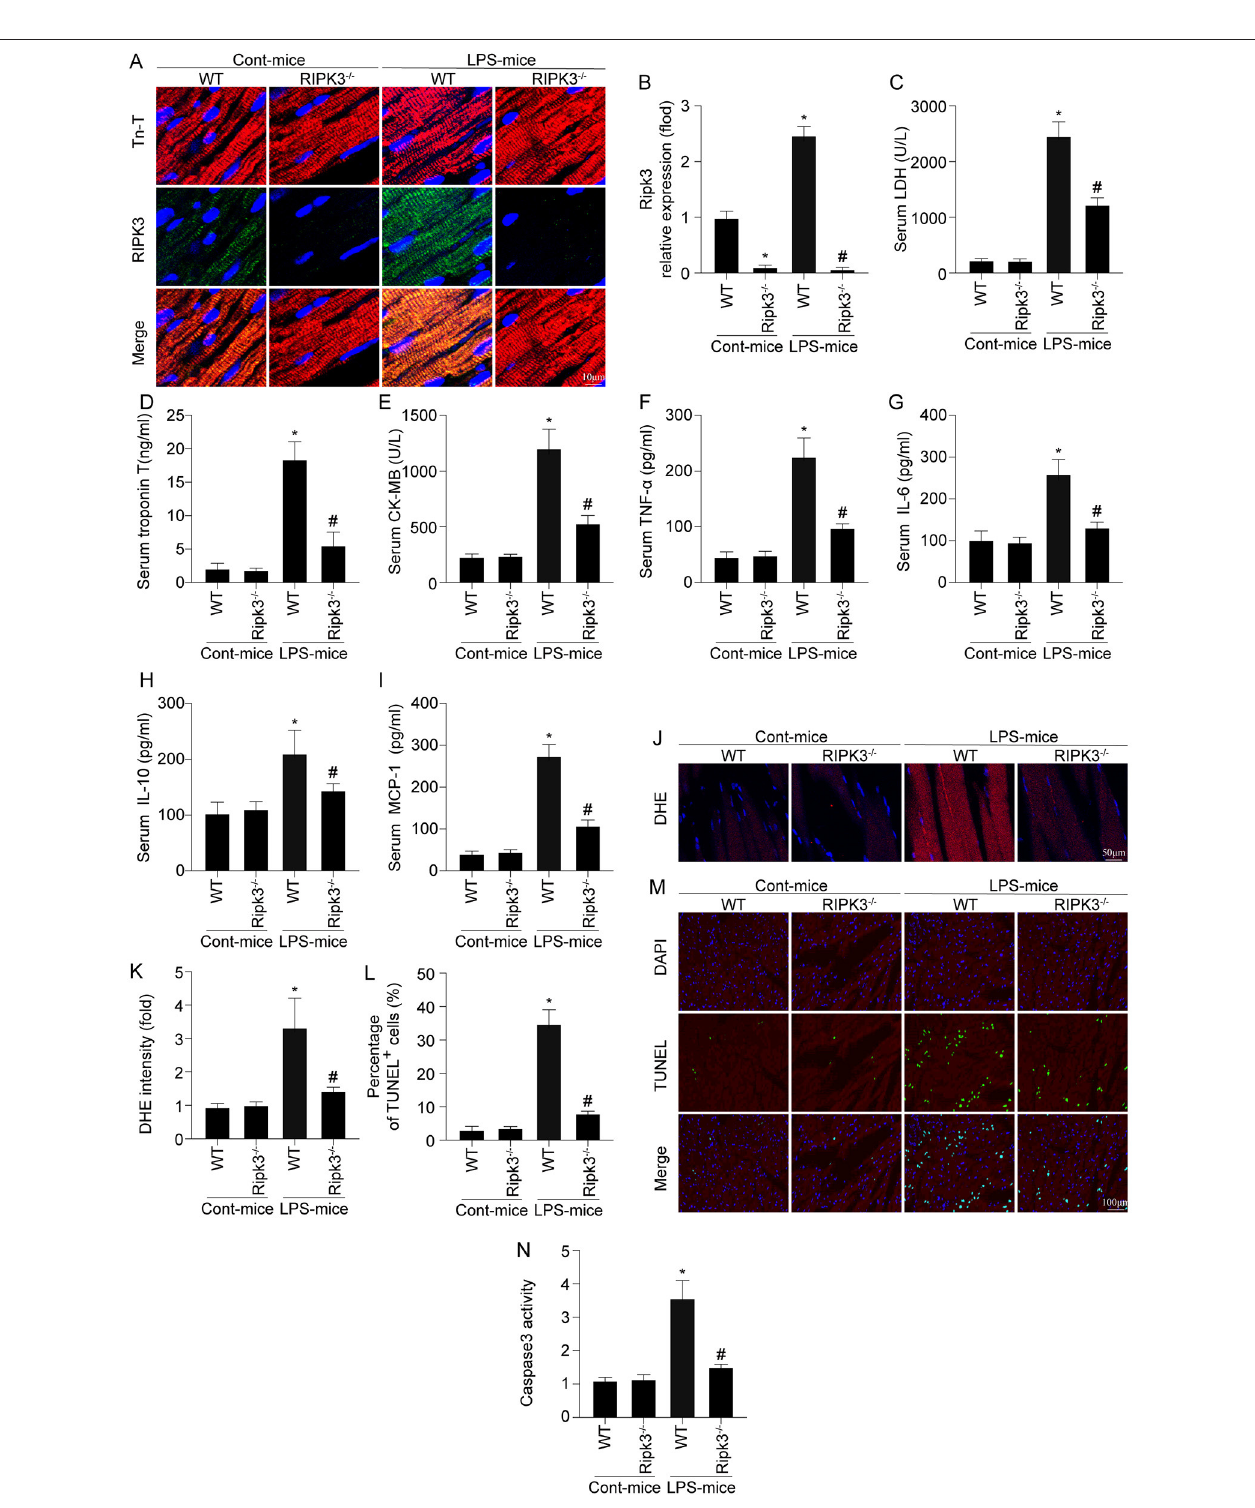
FIGURE 1 | RIPK3 deletion prevents LPS-mediated cardiac injury ( n = 6/group). (A,B) LPS was injected into WT and Ripk3 − / − mice to establish the septic cardiomyopathy model. Then, RIPK3 expression was measures via Immunofluorescence. (C–E) Subsequently, blood was isolated and ELISAs were used to detect the alterations of the cardiac damage markers LDH, CK-MB and Tn-T. (F–I) the concentrations of TNF α , IL-6, IL-10 and MCP-1 in blood were measured via ELISAs. (J,K) The ROS levels in cardiac tissue was detected through DHE staining. TNNEL assay (L,M) and the caspase-3 activity (N) were used to detect cardiomyocyte death. * p < 0.05 vs. WT group. # p < 0.05 vs. WT + LPS